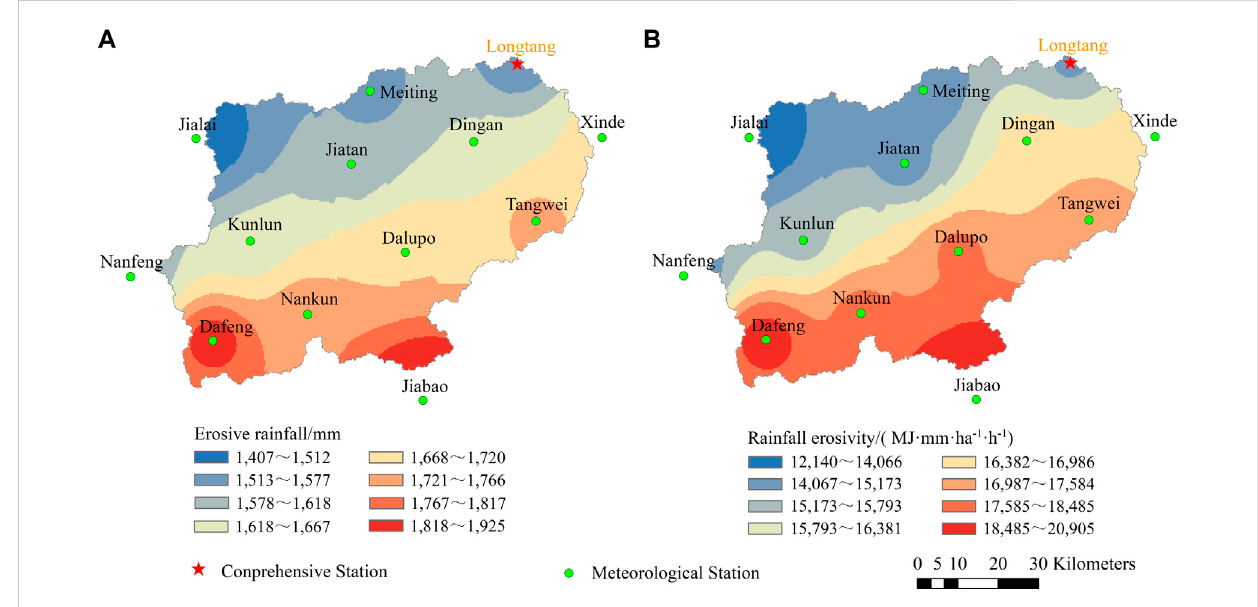
Spatial distribution of erosive rainfall and rainfall erosivity in the Nandu River